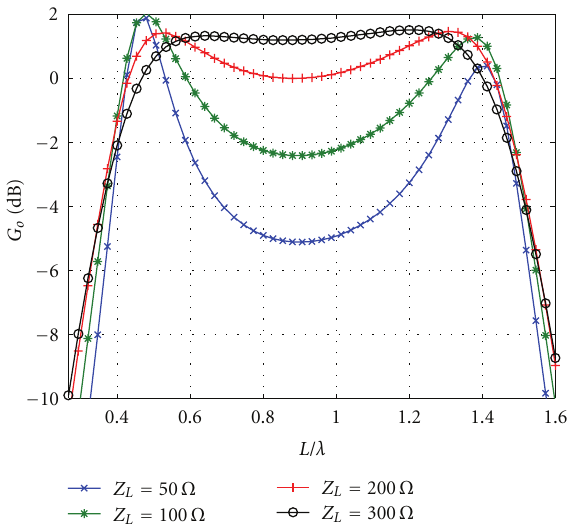
Figure 2: Realized gain of a single vertical dipole of length equal to 1.6 times the smallest operating wavelength, centrally terminated into various values of load impedance Z L